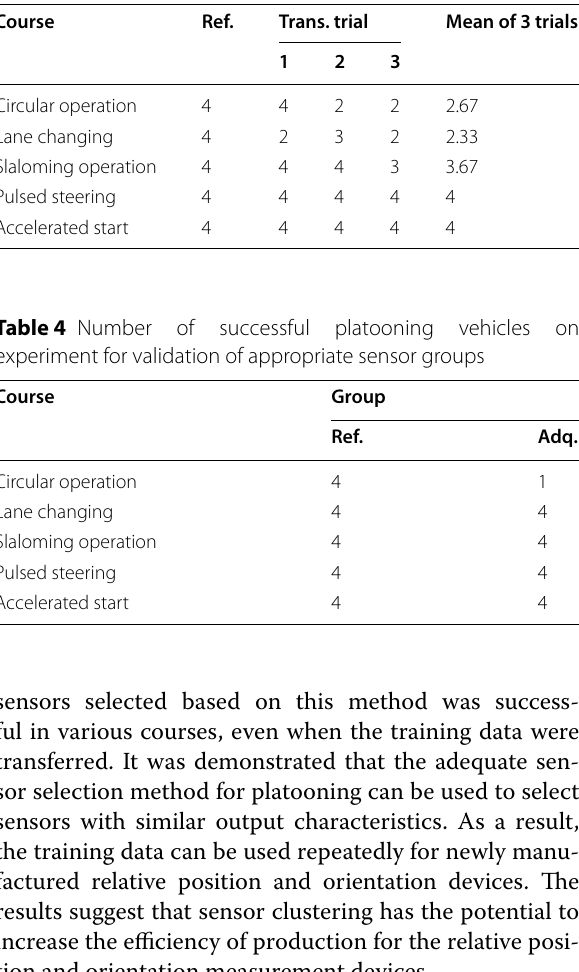
Table 3 Number of successful platooning vehicles on verification experiment